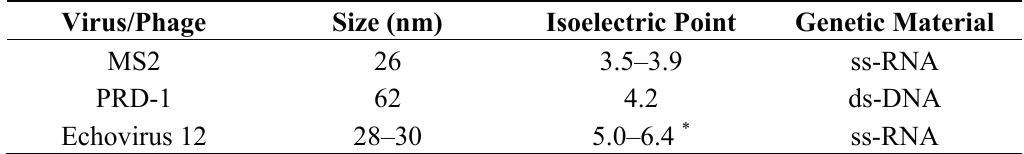
Table 3. Physico-chemical characteristics of filter test